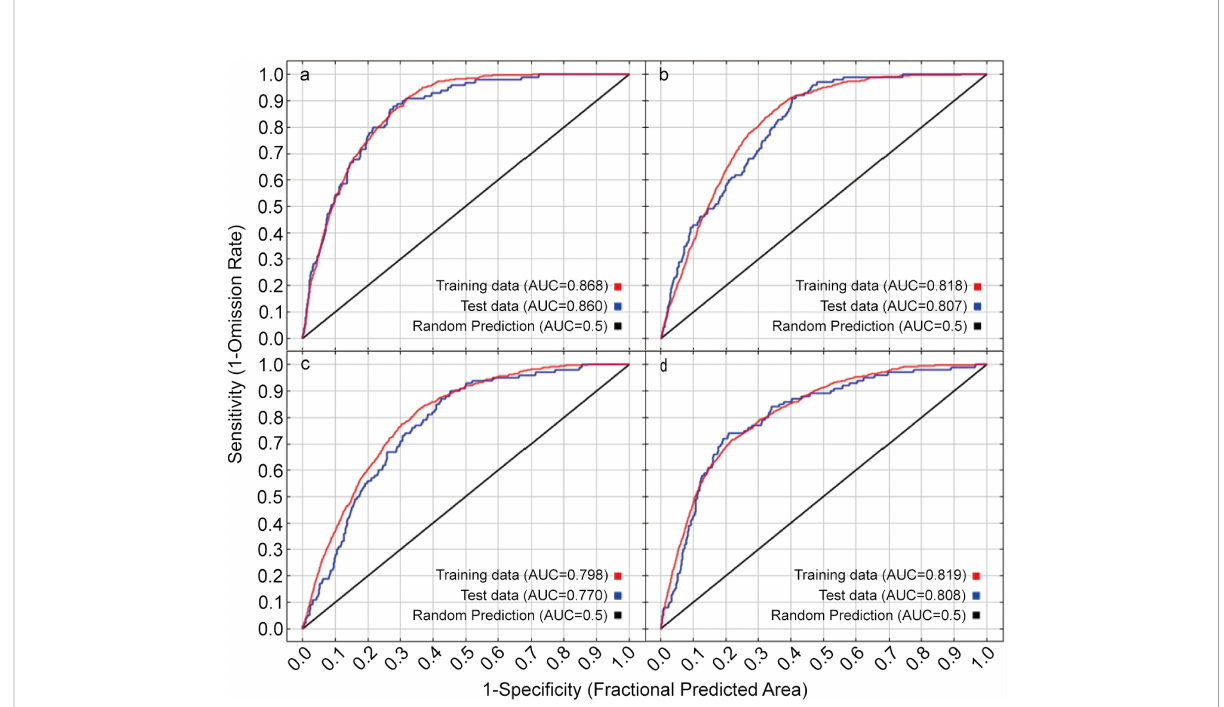
FIGURE 5 Receiver operating characteristic curve (ROC) of the MaxEnt models. Letter a – d in the graph indicates NDVI of high, medium, low, and bare or sparse vegetation